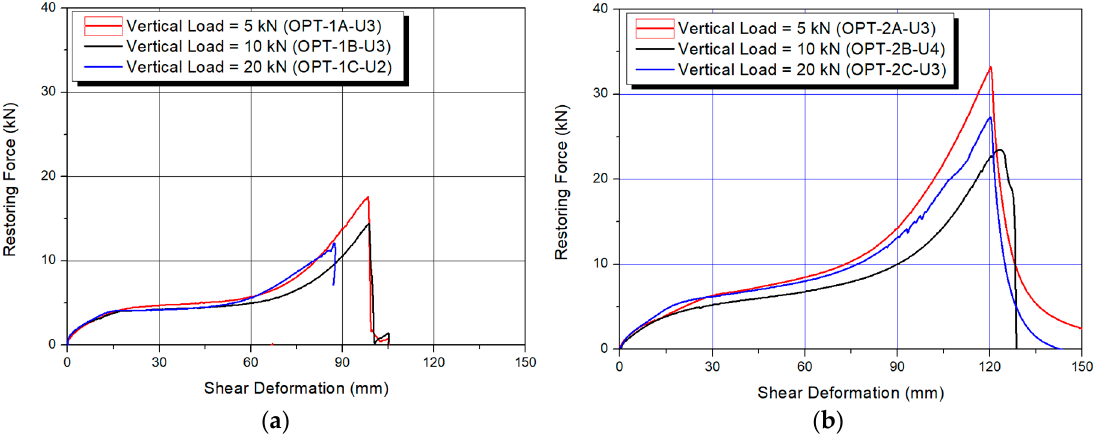
Figure 19. Test results for ultimate shear deformation: ( a ) OPT-1; ( b ) OPT-2.